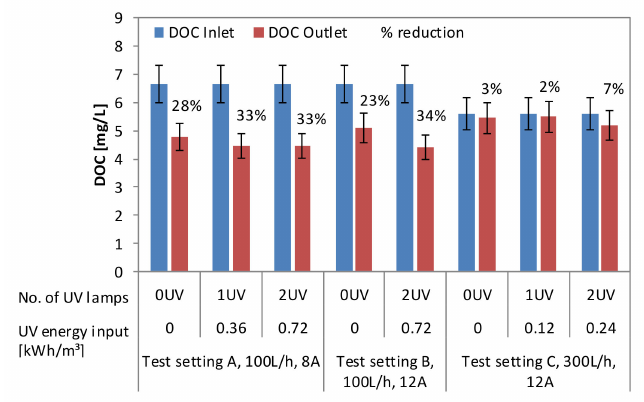
Figure 11. DOC concentrations measured in three di ff erent settings during field tests with Elbe river water.